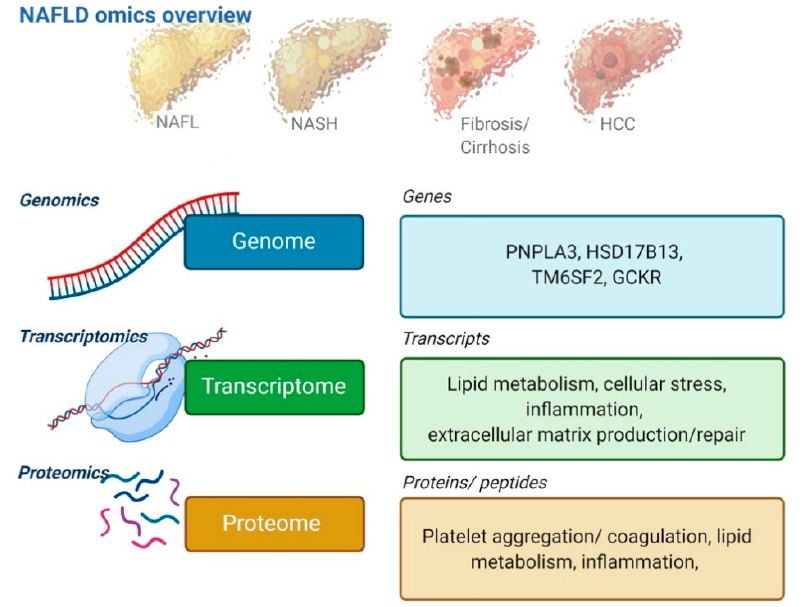
Figure 1. Omics technologies which may mature into implementable biomarkers in the near future; with examples of signals from genomics, transcriptomics, and proteomics that have been associated with NAFLD disease severity.